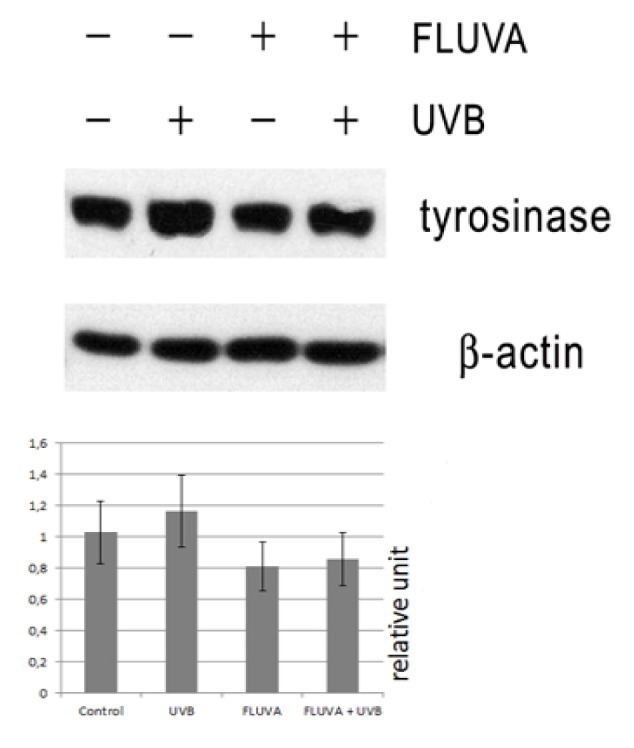
Effect of fluvastatin (FLUVA) and ultraviolet-B irradiation (UVB) on tyrosinase production, as measured by Western blot. β-actin was used as a marker for equal protein loading. The graph presents average levels from four independent Western blots as mean ± SD analyzed using ANOVA test. p > 0.05.